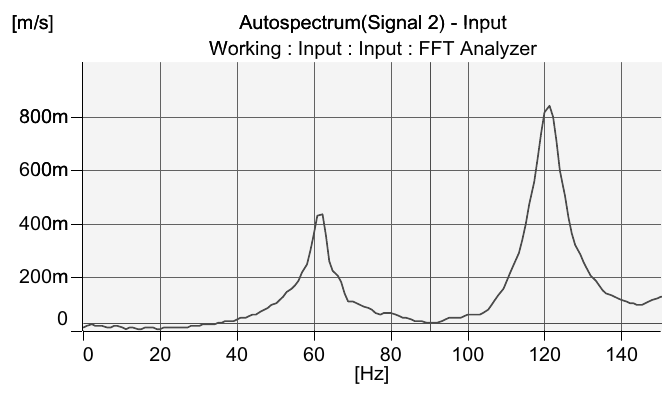
Fig. 5. Frequency response function plot for the simply supported curved box girder bridge model.